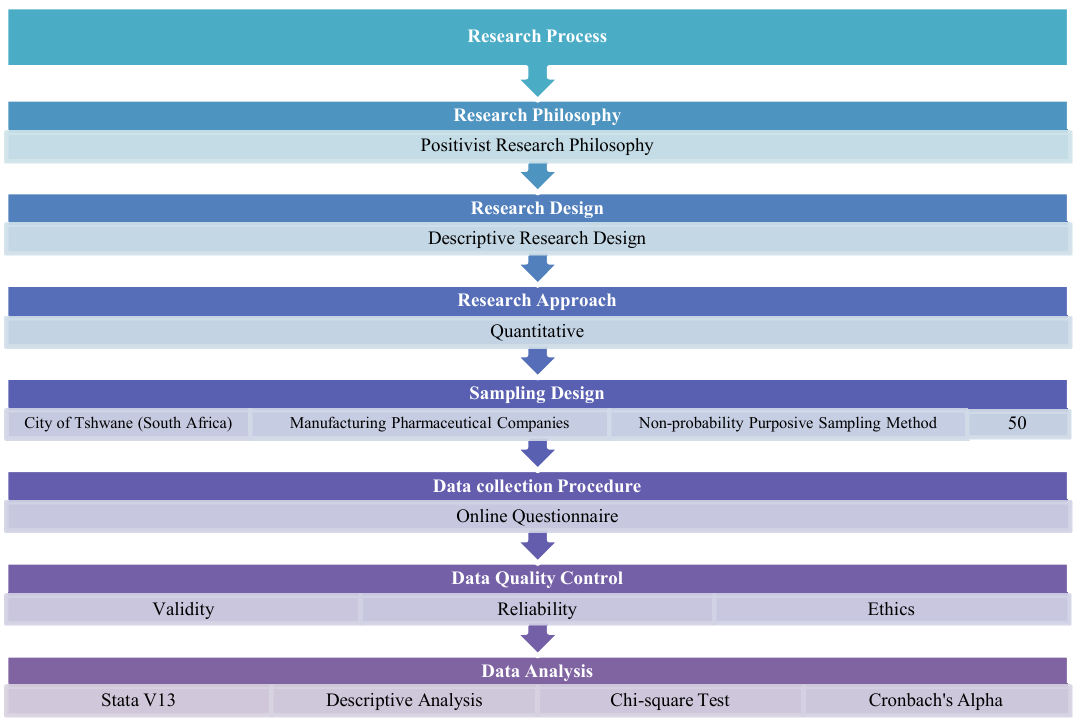
Figure 1. Research design and